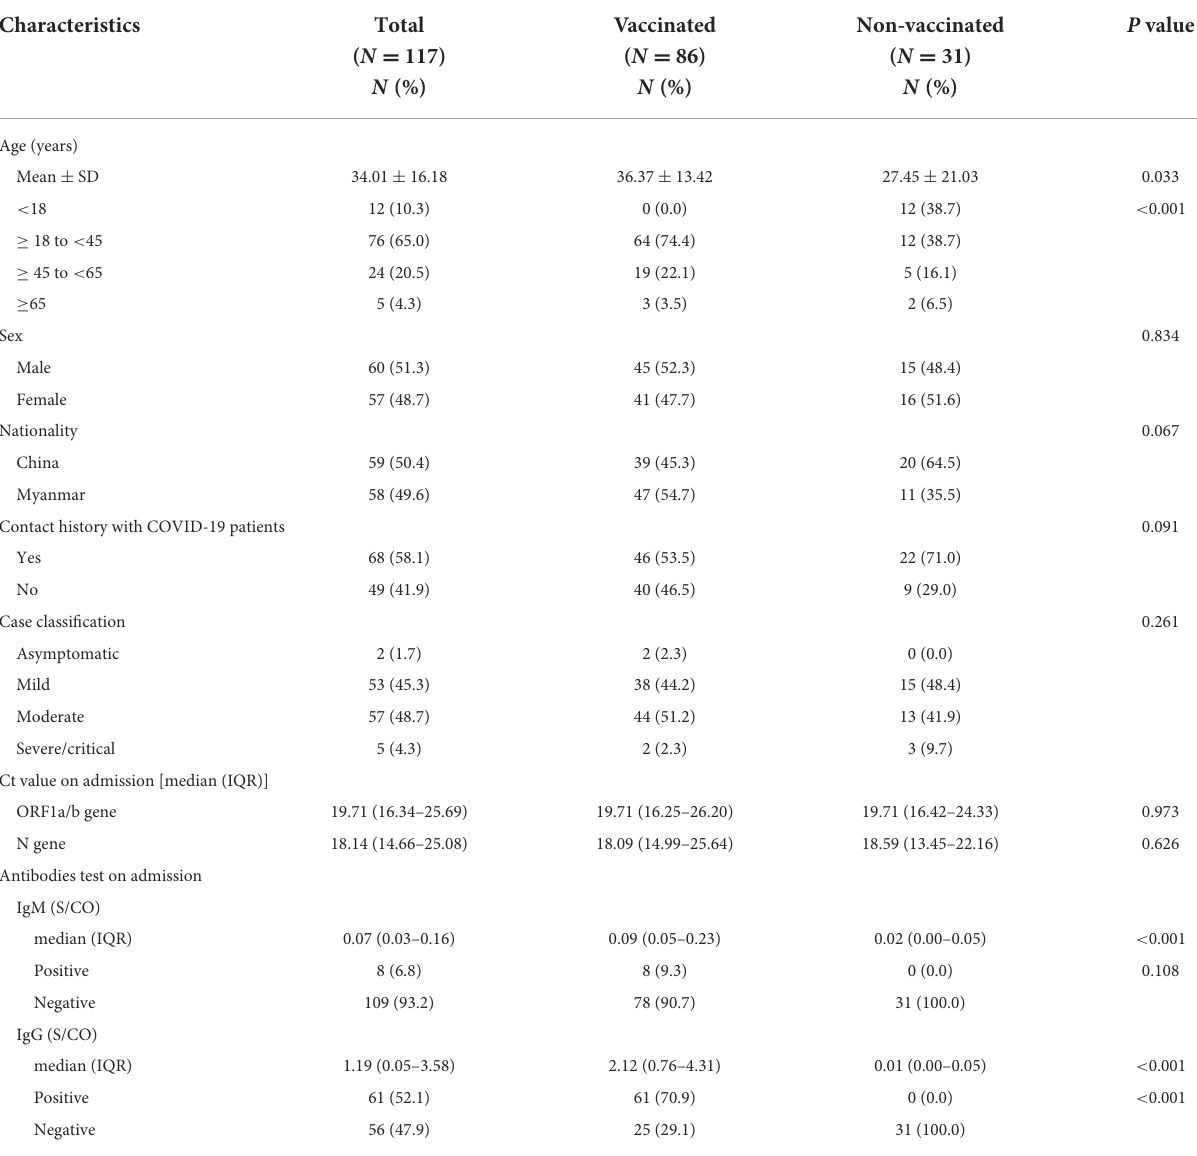
TABLE 1 Characteristics of the 117 confirmed COVID-19 patients during the outbreak.